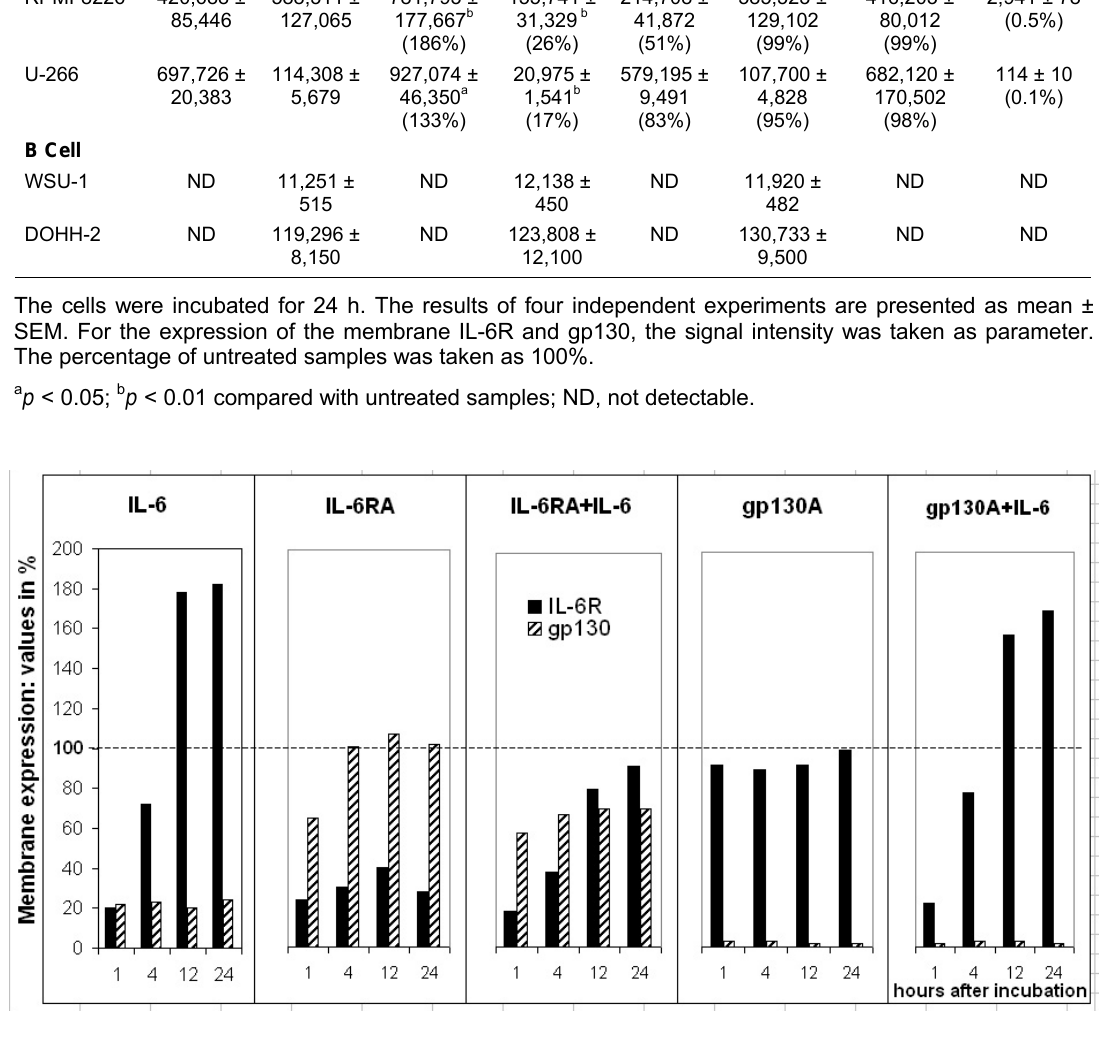
FIGURE 1. The effects of IL-6, IL-6RA, IL-RA + IL-6, gp130A, and gp130A + IL-6 on the membrane expression of IL-6R and gp130 in RPMI-8226 human MM cell line. In two independent experiments, the cells were cultivated for different times with 5 ng/10 6 cells/ml of recombinant human IL-6 or with 0.2 μ g/10 6 cells/ml of human IL-6RA or with 10 μ g/10 6 cells/ml of gp130A or with a combination of these. The mean values of the signal intensity are expressed as percentage of the untreated samples